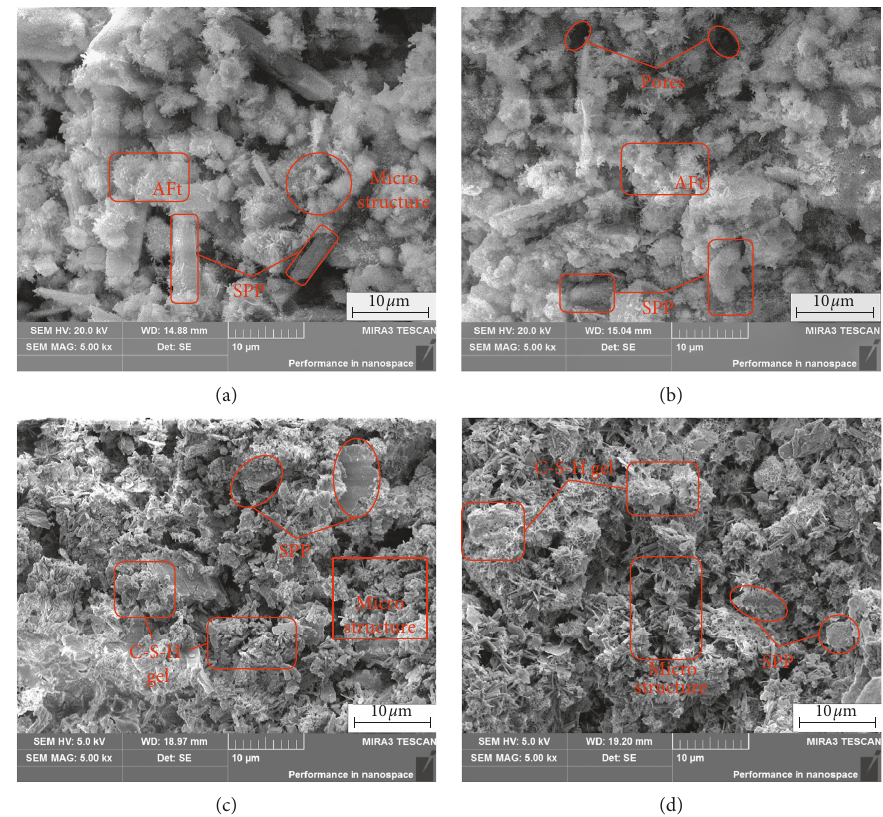
Figure 14: SEM image of the hydration product in the backfill; (a) CTB at 7d; (b) SPCTB at 7d; (c) CTB at 28 d; (d) SPCTB at